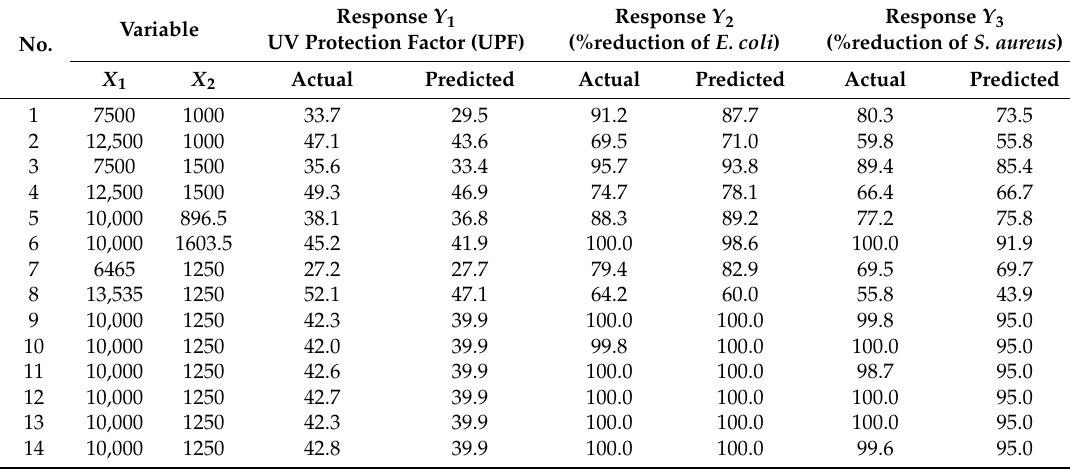
Table 3. Optimum condition for the properties of UPF and antibacterial activity against E. coli and S. aureus of the SS-AgNP